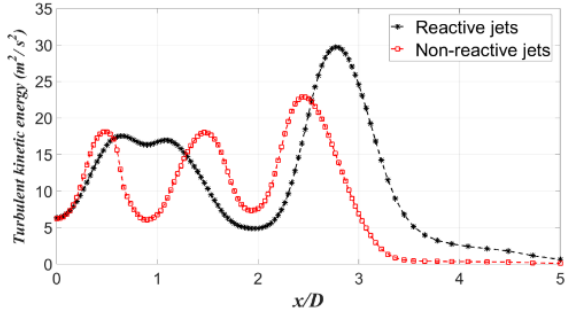
Figure 16. Turbulent kinetic energy distributions of reactive and non-reactive jets (z/D = 5).